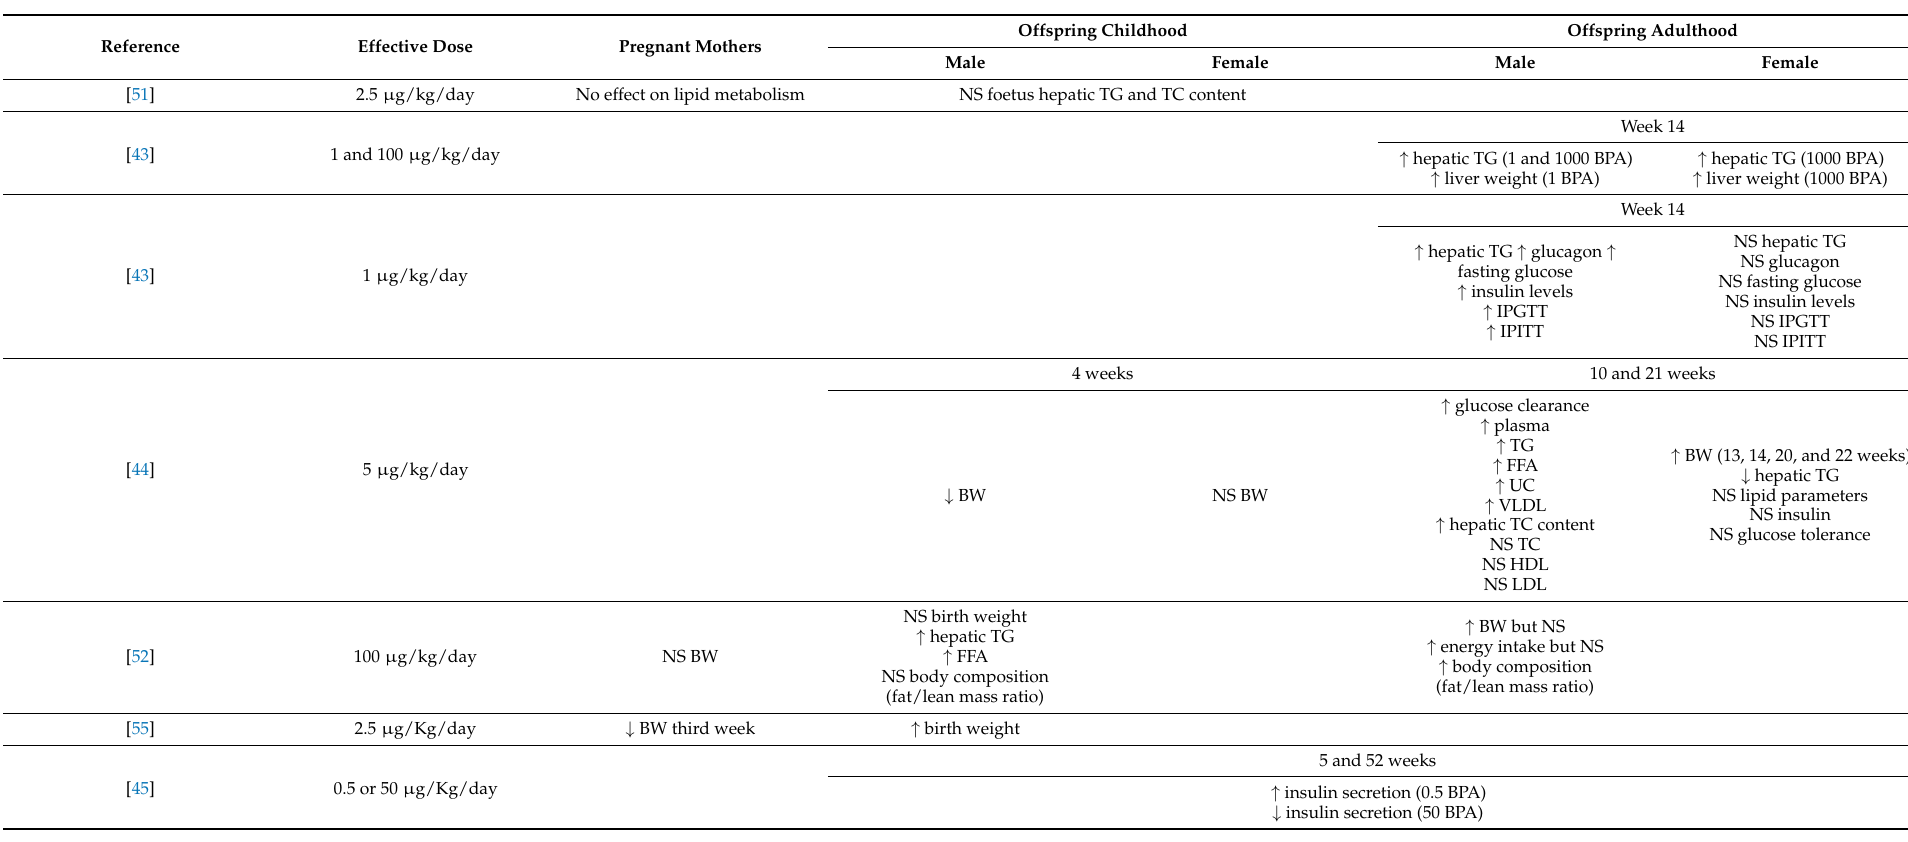
Table A1. Mothers’ exposure to different doses of BPA and the effect on their offspring in childhood and adulthood for animal